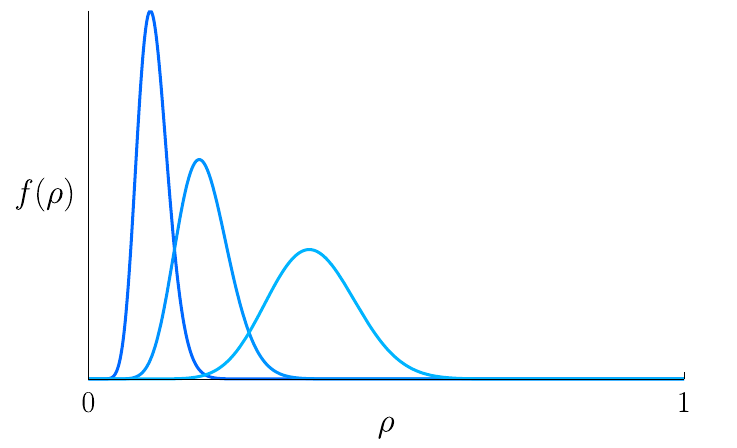
Figure 3 . Plot of normalized smearing function f ( (cid:26) ) in the limit of large R and (cid:1) for decreasing values of R (decreasing shade of